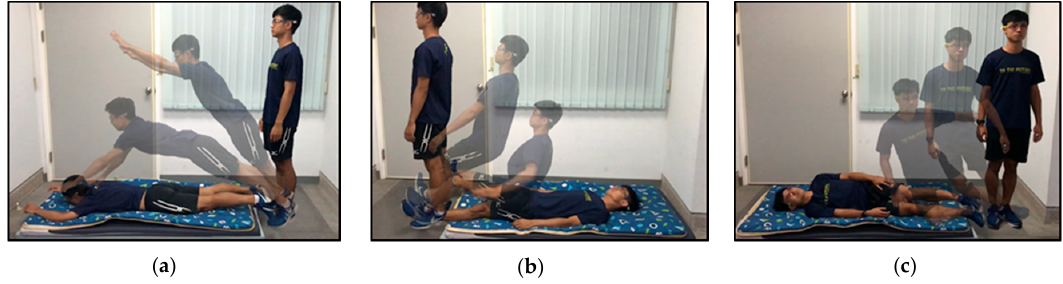
Figure 6. Deployment of test area and falling procedure in our falling experiment. ( a ) Trip fall. ( b ) Slip fall. ( c ) Lateral fall. fall. ( c ) Lateral